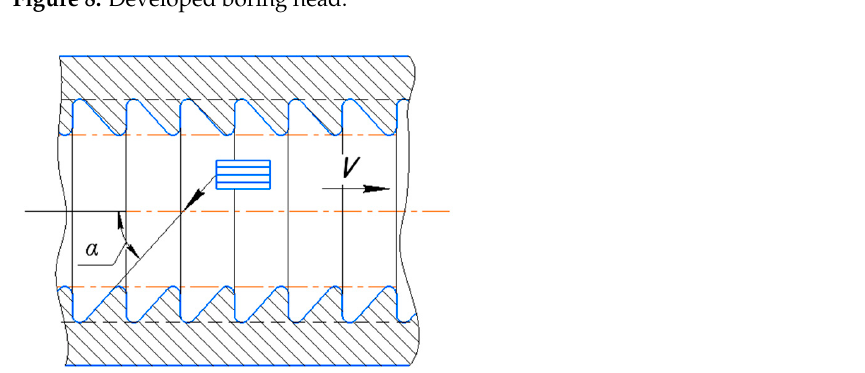
Figure 8. Developed boring head.